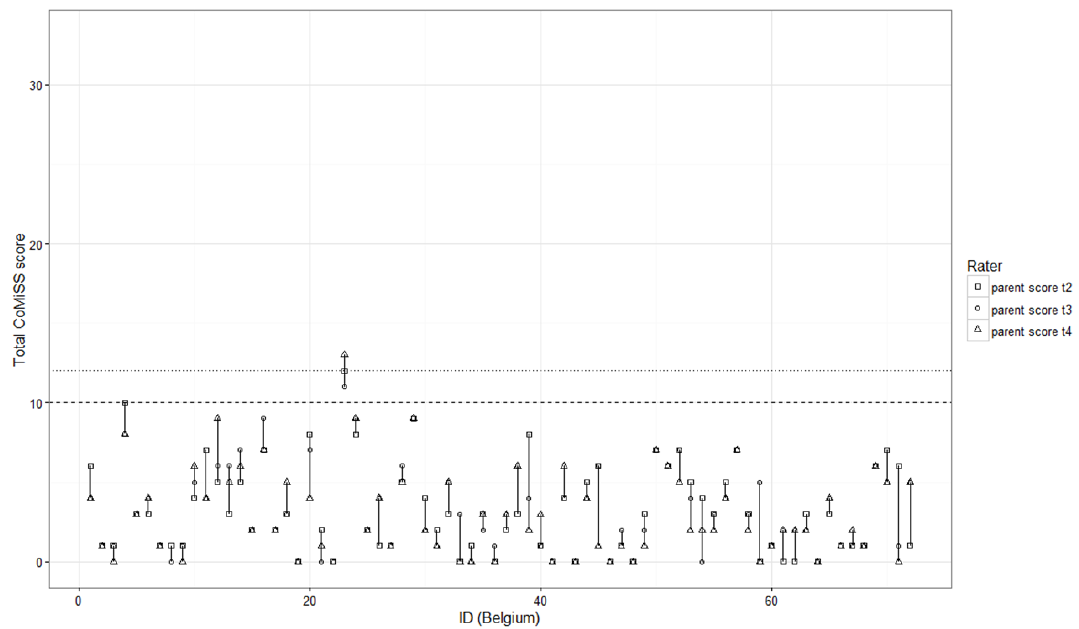
Figure 1. Day to day variability in individual CoMiSS on three consecutive days by a parent. Legend: The dotted line represents the old cut-off values of ≥12 for a positive score, the dashed line the new cut-off of ≥10 for a positive score. This figure represents the individual infants in the X- axis, the Y-axis represents the total CoMiSS as scored by the parents on t 2 –t 4 . The longer the vertical